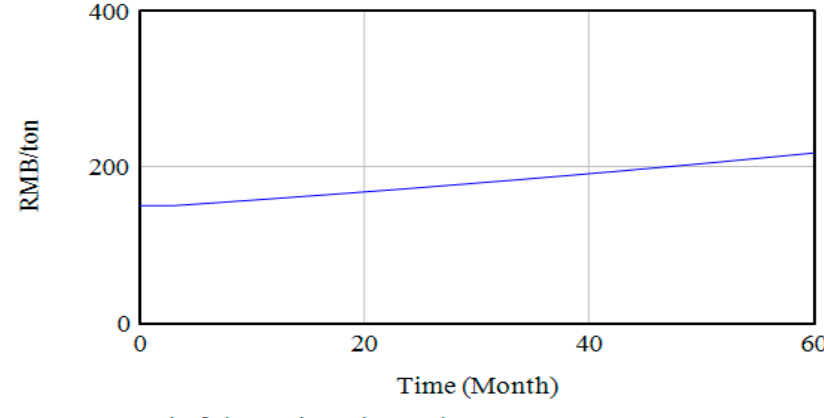
Figure 8. Trend of change in carbon price.